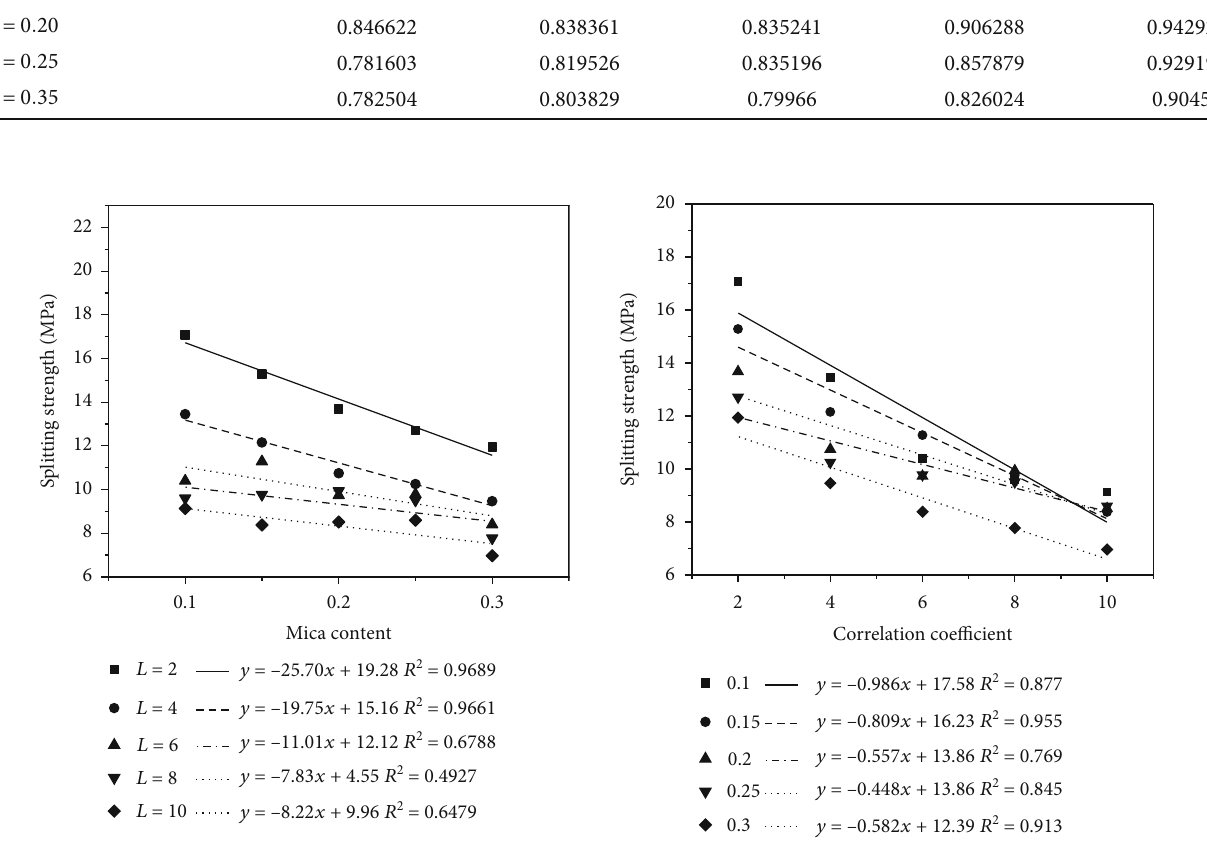
Figure 9: Relationship between di ff erent mineral fabrics and specimen